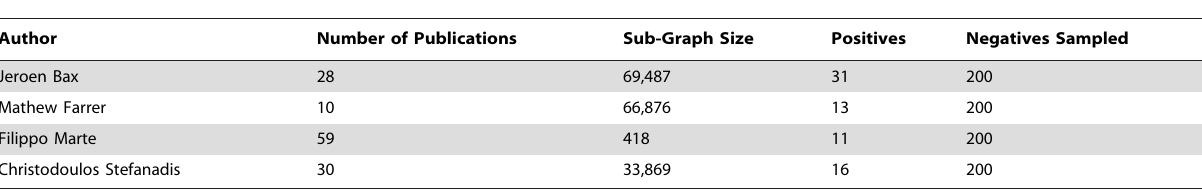
Table 2. IndividualAuthorCategory testing